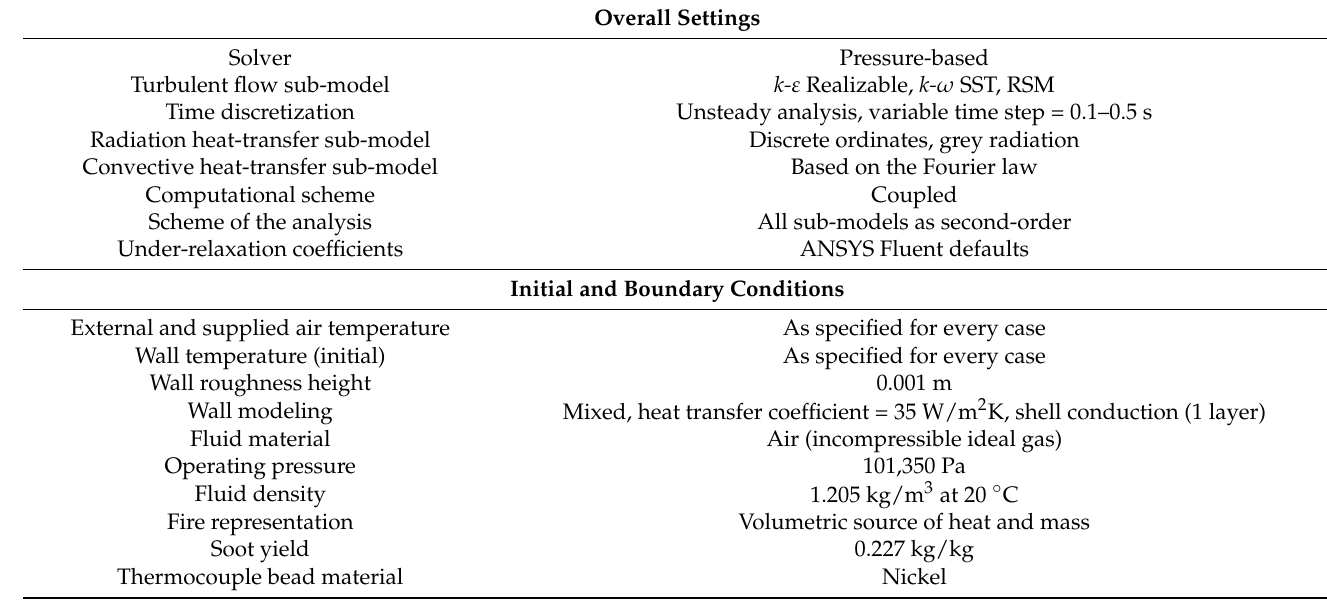
Table 4. Summary of the solver settings in the CFD